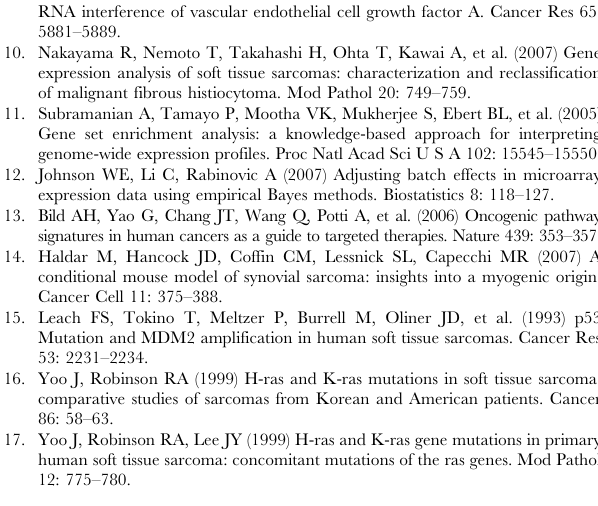
Figure S2 Representative immunohistochemistry for A phos- pho-ERK and B FOXM1 show strong nuclear staining from the same human tumor sample. All scale bars represent 100 microns.